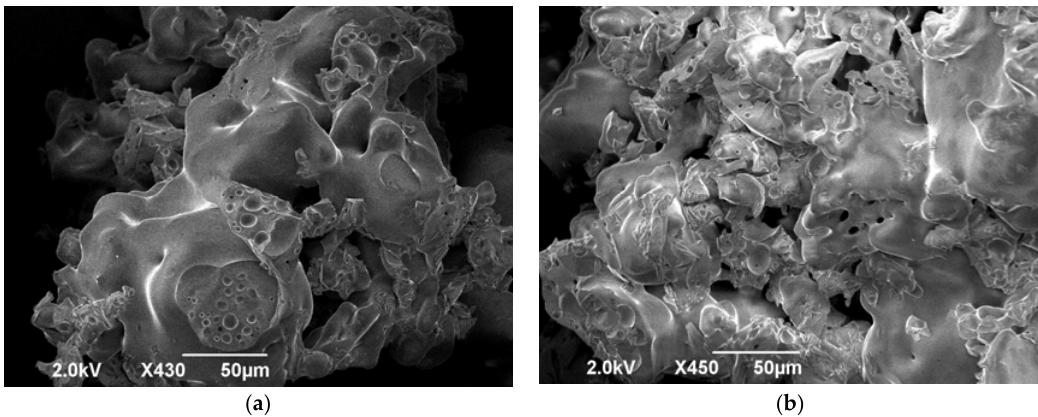
Figure 1. SEM images of the activated carbon samples prepared by hydrothermal treatment. (a) one particle; (b) second